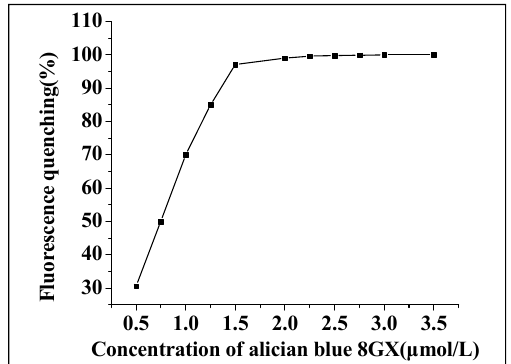
0.5 1.0 1.5 2.0 2.5 3.0 3.5 Figure 8. The effect of dosage of Alcian blue 8GX on the degree of fluorescence quenching of the system. The concentrations of AlS 4 Pc and Hg (II) were 1.0 × 10 − 6 mol/L and 1.0 × 10 − 5 mol/L, respectively.